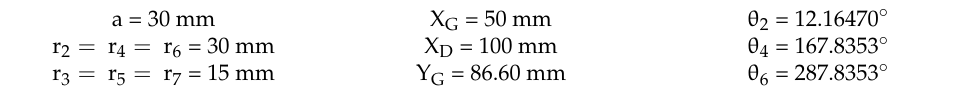
Table 5. Physical dimensions for the planar manipulator.